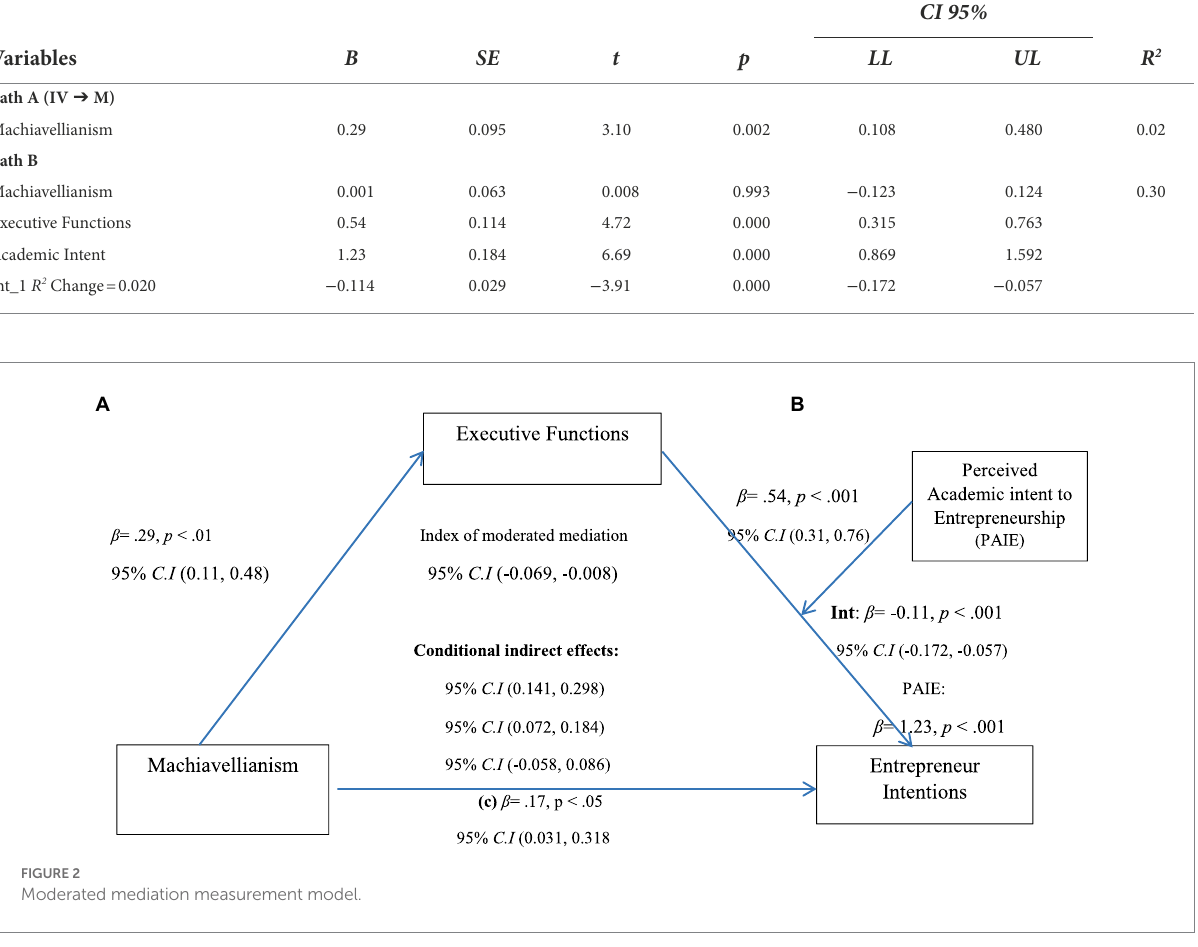
TABLE 6 Models summary for Path A and Path B.